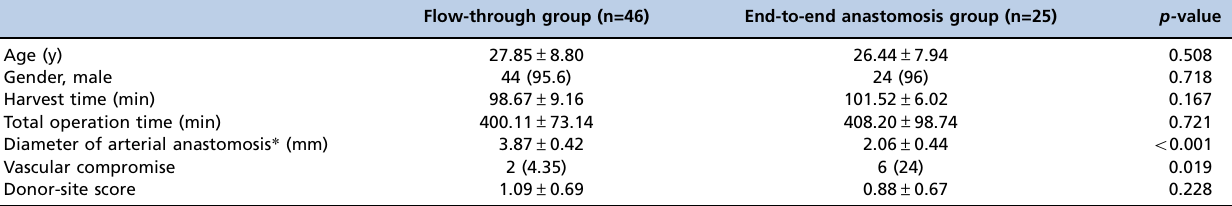
Table 1 - Patient characteristics and outcomes